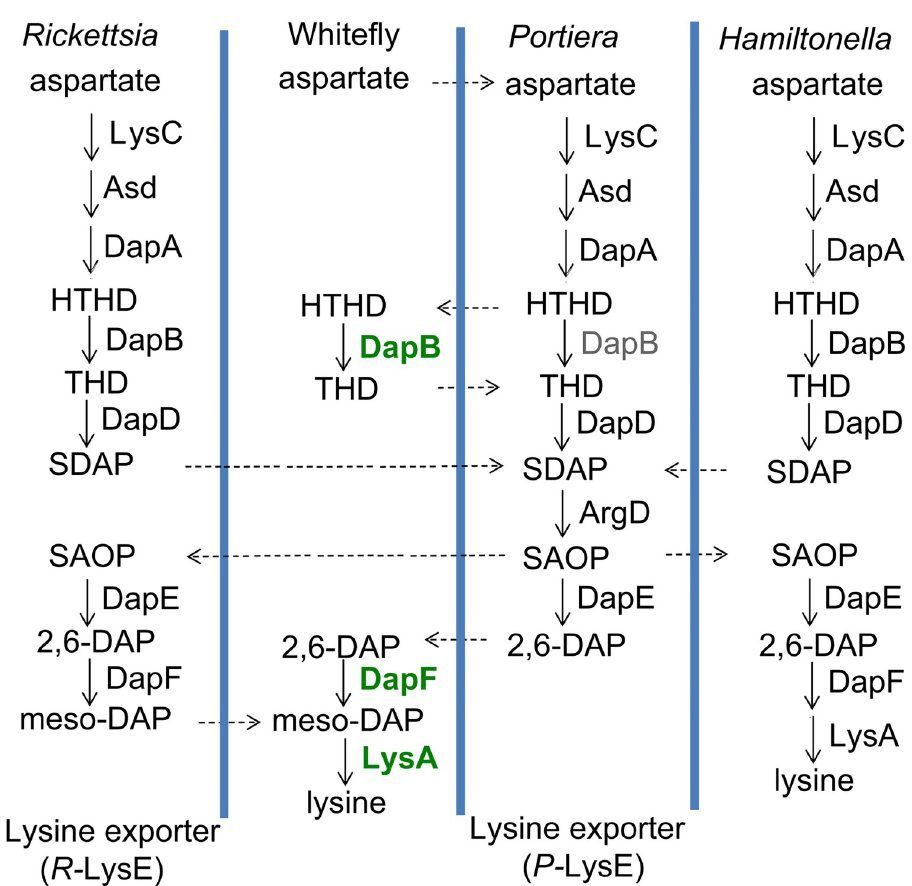
Fig 1. Lysine synthesis pathway in B . tabaci MEAM1. This figure is adapted from previous work (9, 29). HTHD, 4-hydroxy-2,3,4,5-tetrahydrodipicolinate; THD, 2,3,4,5-tetrahydrodipicolinate; SDAP, N-succinyl-L- 2,6-diaminoheptanedioate; SAOP, N-succinyl-L-2-amino-6-oxoheptanedioate; 2,6-DAP, 2,6-diaminopimelate; meso- DAP, meso-2,6-diaminopimelate. Pseudogene is in grey and enriched host genes of bacterial origin are in green. The exchanges of intermediates among Portiera , Hamiltonella and Rickettsia are